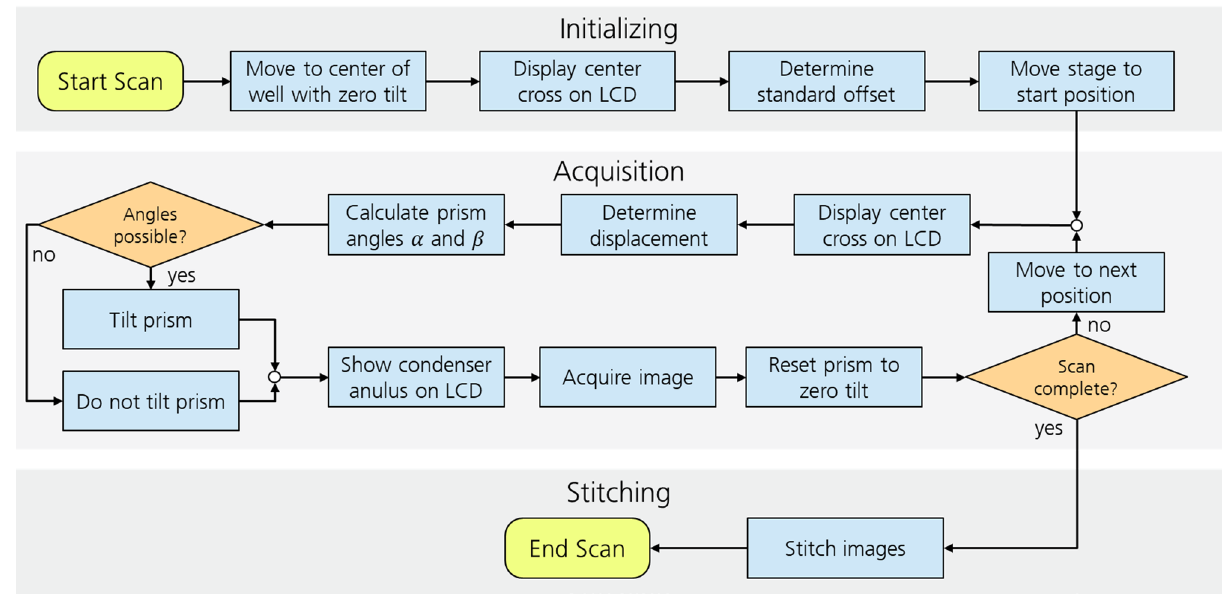
Figure 5. Flowchart of the image acquisition process. The process can be divided into three parts: Initialization, acquisition, and stitching. Initialization and stitching are only done once, at the beginning and end of the process, respectively. The acquisition process is repeated for every